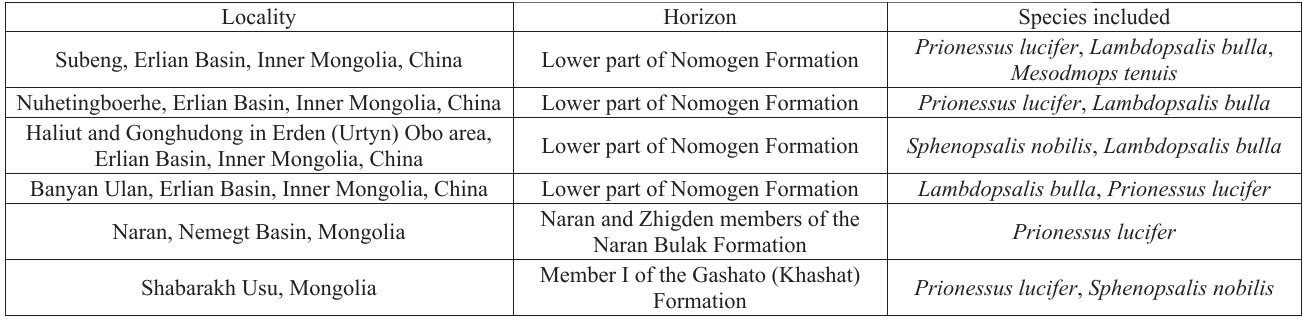
Table 1. Multituberculates from the late Paleocene localities of the Mongolian